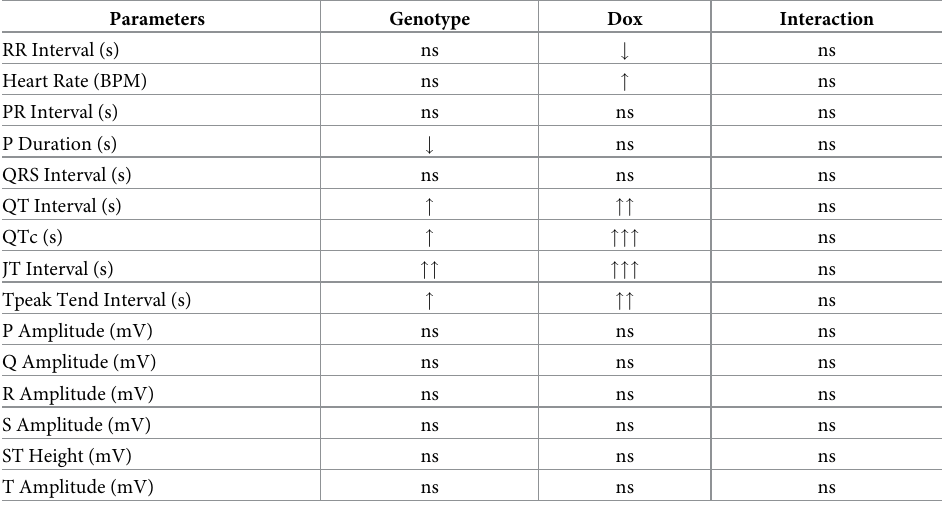
Table 2. Summary of results of two-way ANOVA of telemetry ECG analysis for WT and Zip13 -KO